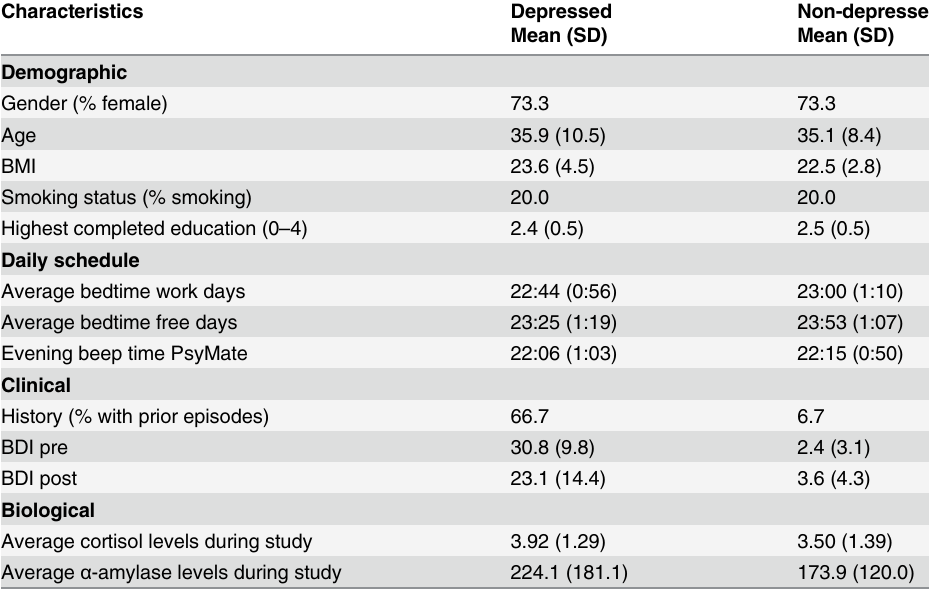
Table 1. Characteristics of depressed and non-depressed groups.